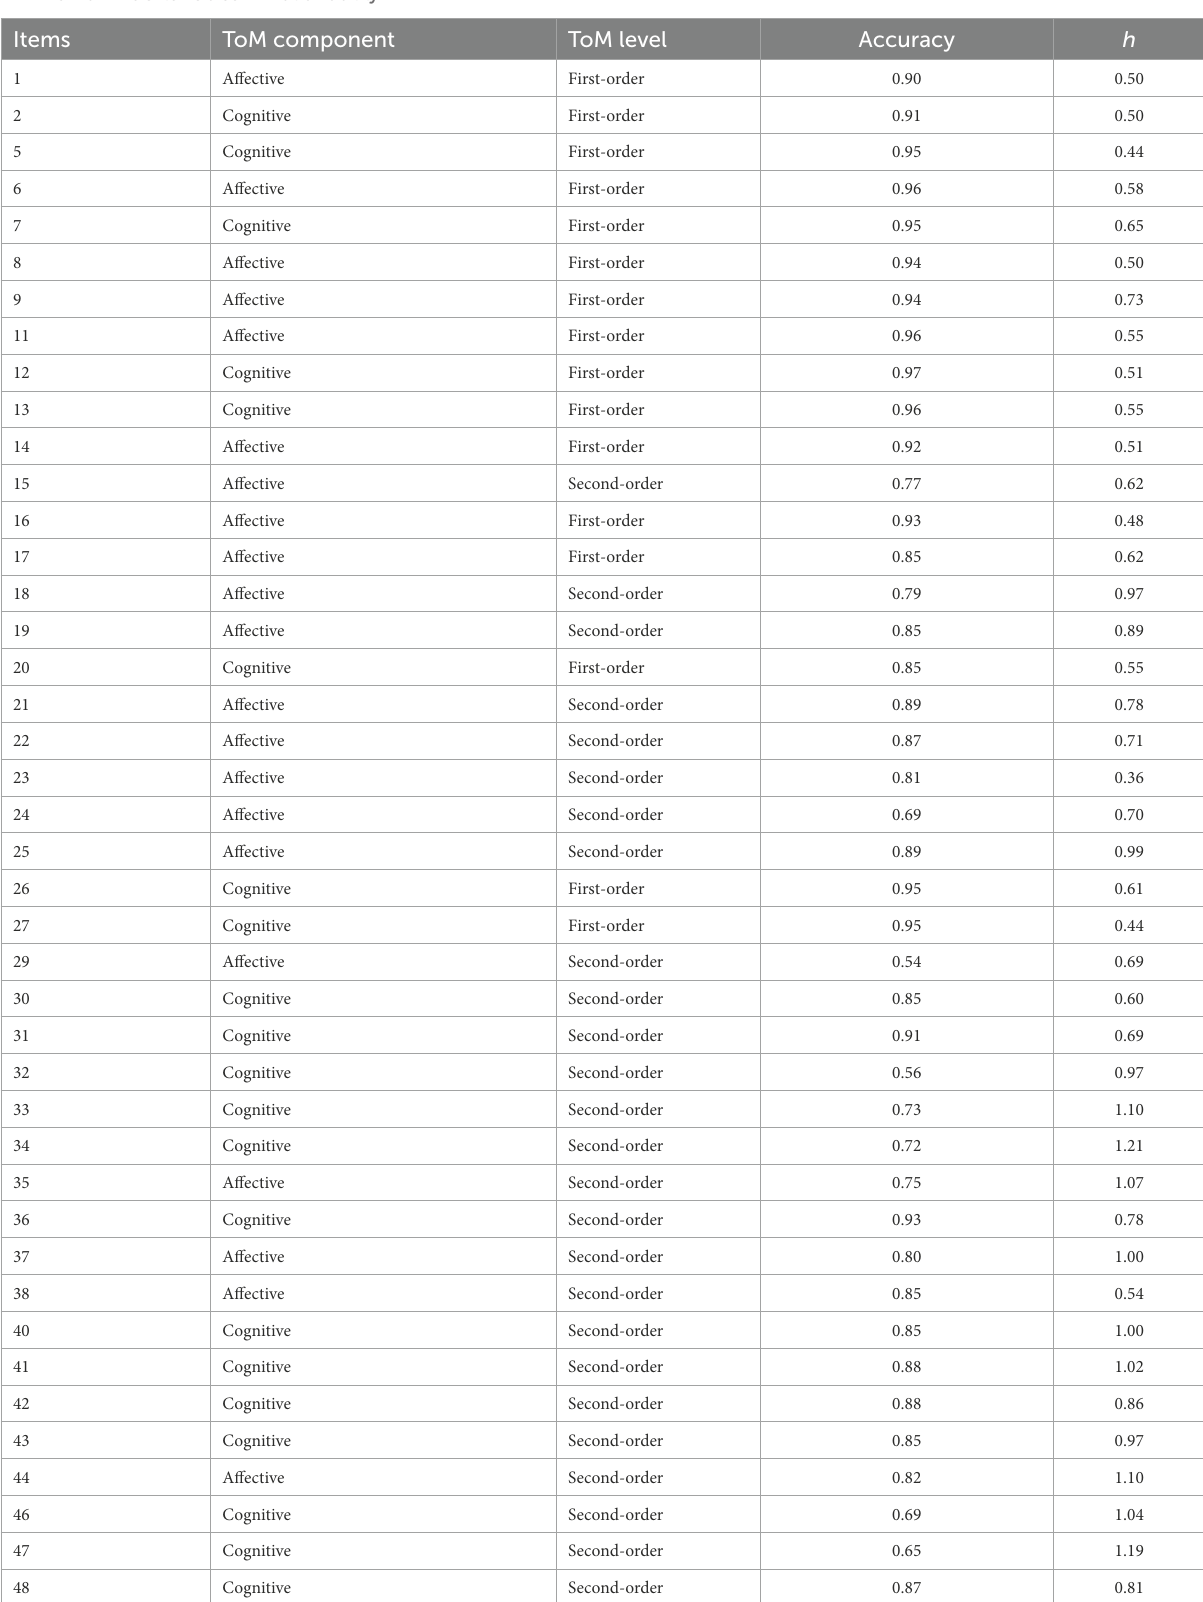
TABLE 3 Yoni-48’s items discrimination